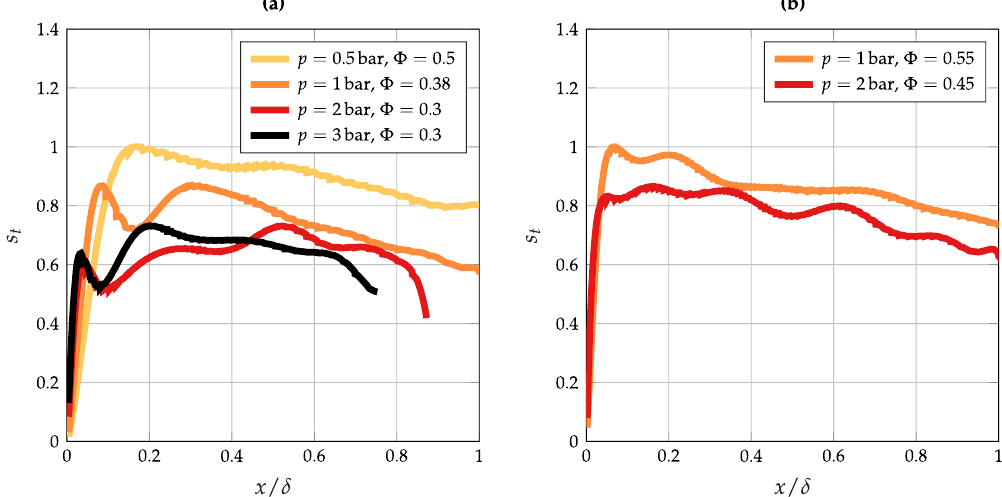
Figure 10. Comparison of turbulent flame speeds at different pressure levels for ( a ) U b = 10ms − 1 and for ( b ) U b = 20ms − 1